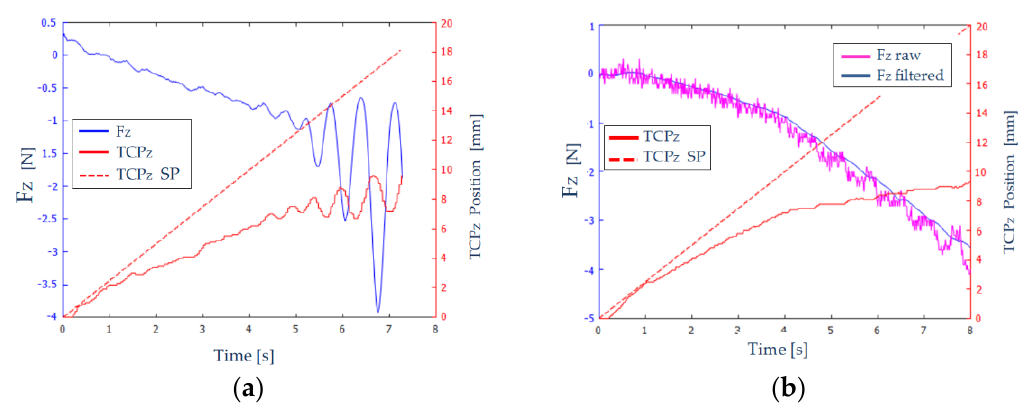
Figure 10. Results obtained in scenario 2. ( a ) Forces (blue) and position (red) on the Z axis of the robot’s TCP for 𝐾 𝐹 = 5 mm/N ( b ) Forces (unfiltered force–violet line, filtered force–blue line) and position (red) on the Z axis of the robot’s TCP for 𝐾 𝐹 = 3 mm/N .